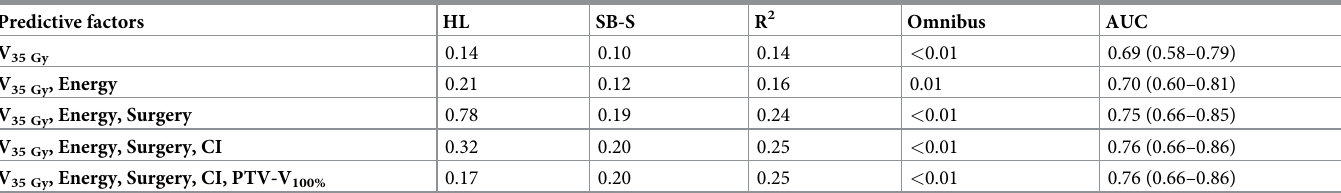
Table 4. System performance evaluation.